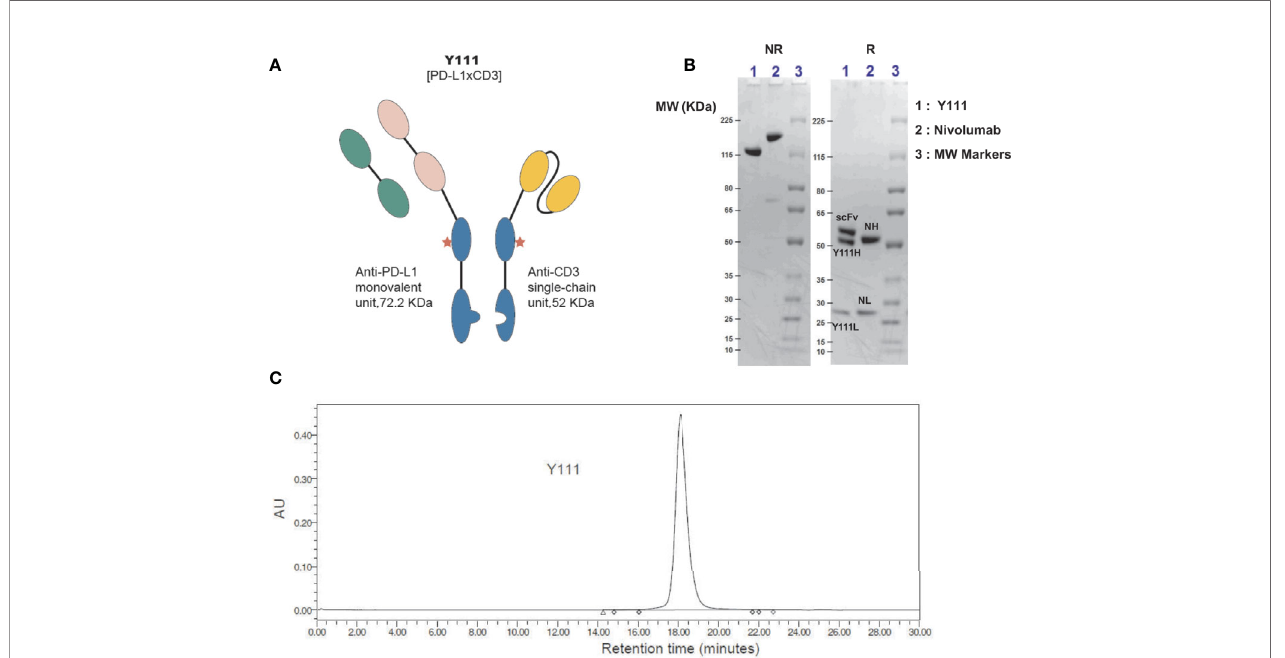
FIGURE 1 | Generation and puri fi cation of Y111, a bispeci fi c antibody targeting both CD3 and PD-L1. (A) Schematic diagram of bispeci fi c antibody Y111, which consists of a monovalent unit adapted from Tecentriq, a monoclonal antibody targeting PD-L1, and a single-chain variable fragment (scFv) from 2A5 (27), a monoclonal antibody for CD3 activation. The red asterisk indicates N297Q mutation for precluding Fc receptor-mediated crosslinking. (B) SDS-PAGE analysis of the puri fi ed Y111 under non-reducing (NR, left) and reducing (R, right) conditions. Nivolumab is a monoclonal antibody used as a control. Molecular weight (MW) is indicated in KDa. The MW of Y111 is a little smaller than the monoclonal antibody Nivolumab as indicated from NR gel. There are 3 and 2 bands for Y111and Nivolumab in reducing gel respectively as expected. Please note that the nominal MW of Y111H is 48.850 KDa, Y111L is 23.365 KDa, scFv is 52.057 KDa, and intact Y111 is 124.272 KDa as predicted by their protein sequences. The predicted nominal MW of Nivolumab is 143.597 KDa, the predicted MW of heavy (NH) and light (NL) chain of Nivolumab is 48.422 KDa and 23.359 KDa, respectively. (C) Size-exclusion chromatograms of Y111 puri fi ed by Protein-A and ion-exchange chromatography. The purity for this Y111 sample is